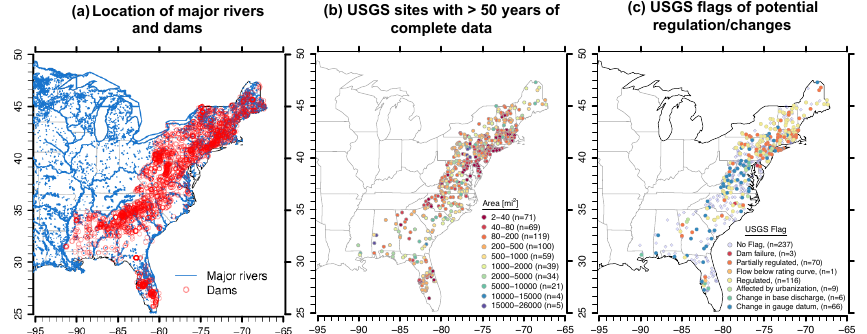
Figure 1. (a) Location of 2352 major dams in the eastern US. (b) Location of the 508 streamflow sites with 50 years or more of complete daily data. (c) Flagged sites according to the USGS.